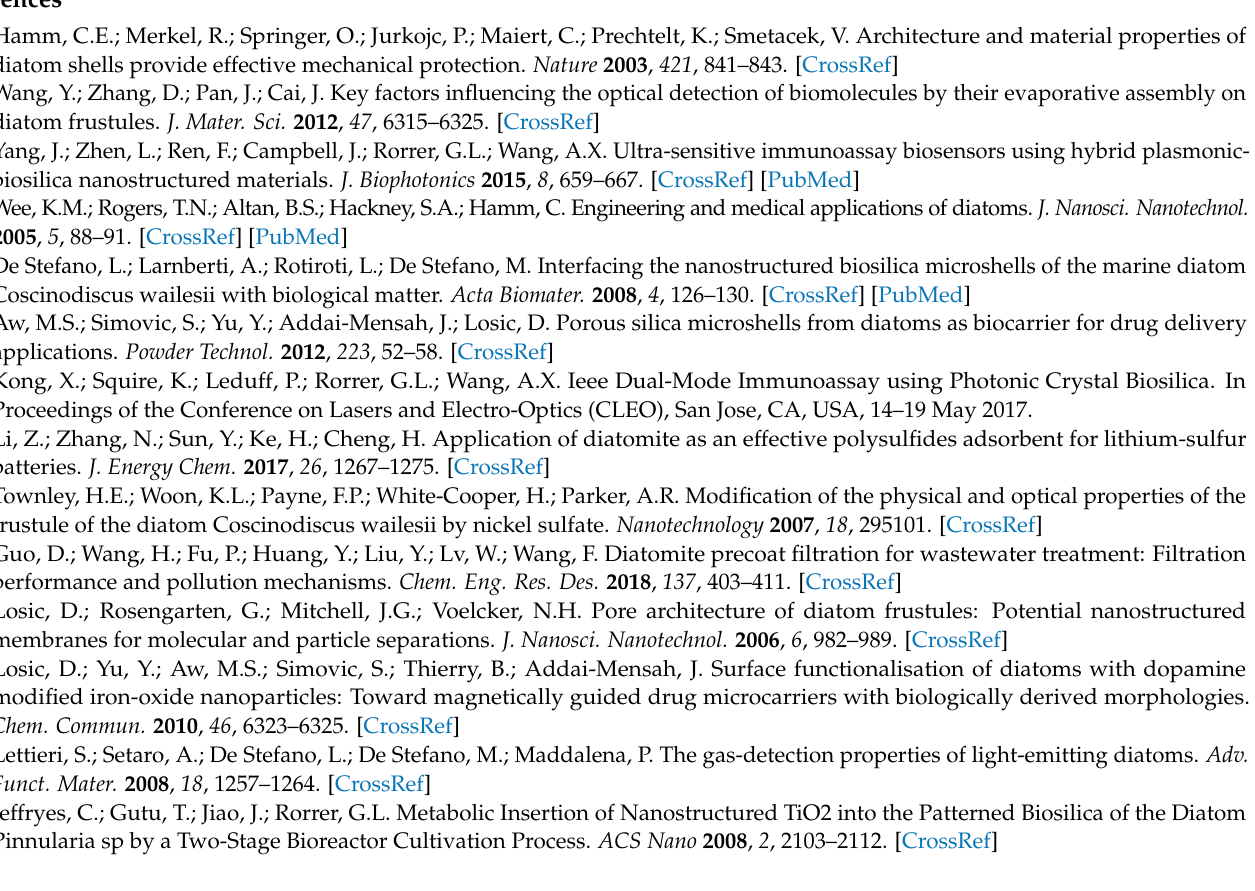
frustules; Figure S3: Optical images of micro holes with hot-melt glue; Figure S4: SEM images of (a,c) diatom frustules array, that (b,d) bonded to the Si by hot-melt glue; Figure S5: (a) Schematic illustrations of manipulating diatom frustules into array pattern; (b) Pictures of micromanipulator system; Figure S6: Microfluidics chip bonding; Figure S7: Simulation model for the comparison of concentration between flow-through and flow-over a frustule; Figure S8: Simulation model for the flow filed profile in an individual cell and particles adsorption on the surface of the cell; Figure S9: Two-phase flow simulation of water passing through an individual cell of